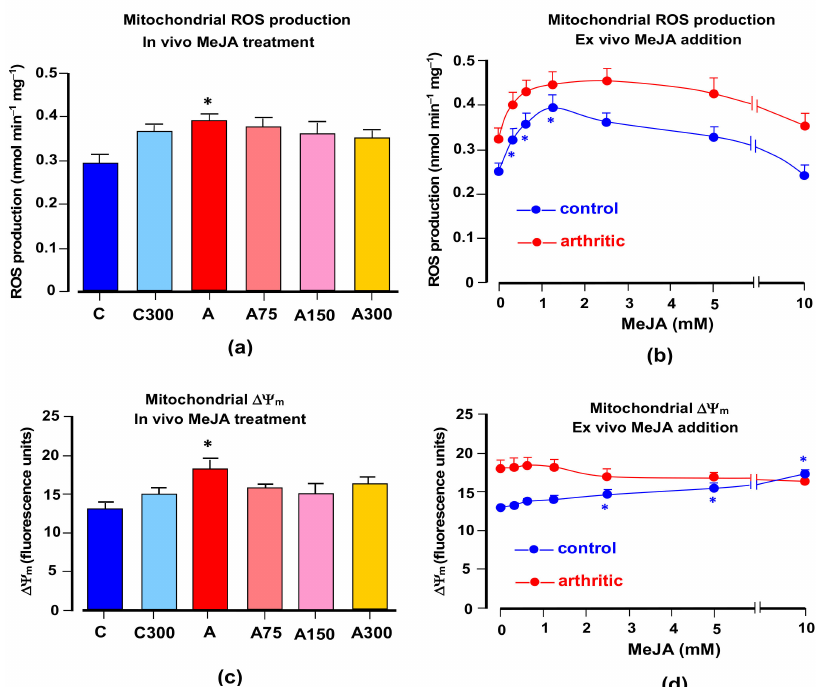
Figure 3. E ff ects of MeJA on ROS production and membrane potential in brain mitochondria from healthy and arthritic rats. ( a ) ROS production in mitochondria isolated from healthy and arthritic rats, treated or not with di ff erent MeJA doses (C, controls; C300, controls treated with 300 mg / kg MeJA; A, arthritic rats; A75, A150 and A300, arthritic rats treated with 75, 150 and 300 mg / kg MeJA, respectively). ( b ) ROS production by brain mitochondria isolated from healthy and arthritic rats and incubated with varying concentrations of MeJA. ( c ) Membrane potential ( ∆Ψ m ) of brain mitochondria isolated from healthy and arthritic rats, treated or not with di ff erent MeJA doses. ( d ) Membrane potential ( ∆Ψ m ) of brain mitochondria isolated from healthy and arthritic rats and incubated with varying concentrations of MeJA. Data are the means ± standard errors of the mean of five animals for each experimental condition. Statistical analysis: ANOVA one-way with Newman–Keuls post-hoc testing. * p < 0.05, di ff erent from the corresponding